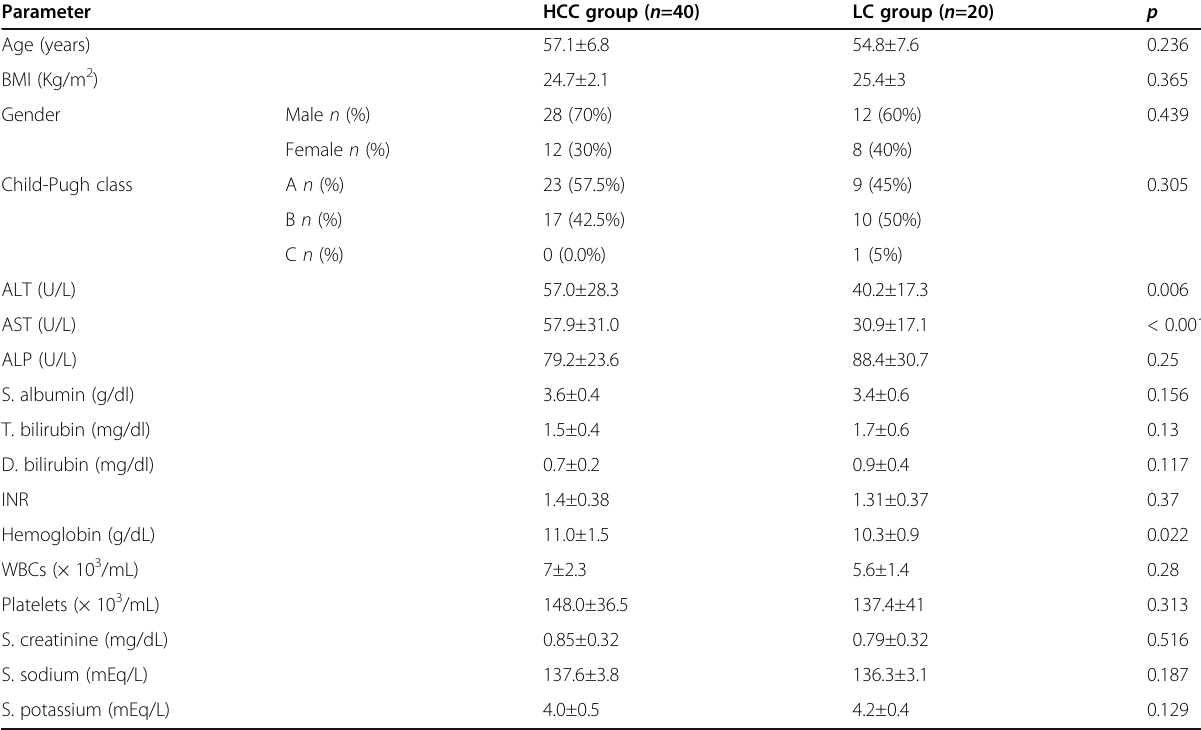
Table 1 Demographic and laboratory data of studied